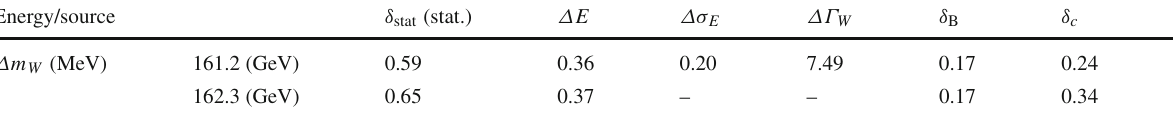
Table 2 The precision of m W when taking data at E = 161 . 2 or 162 . 3 GeV. Shown in the table are the statistical and systematic uncertainties on m W . The last column is the total uncertainty at the corresponding energy point Energy/source